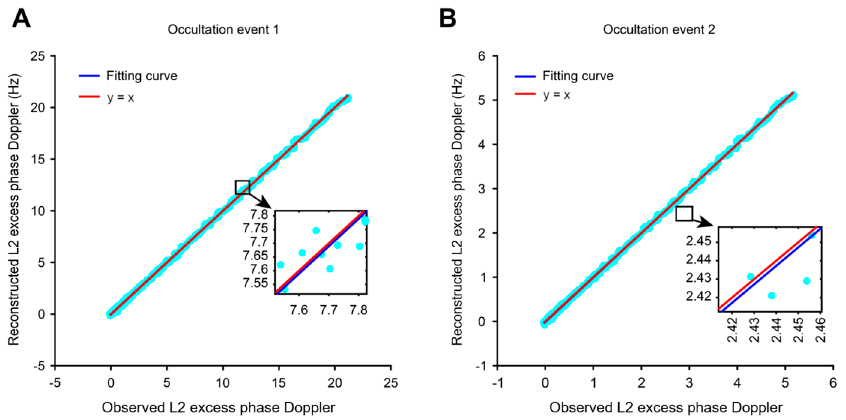
Figure 5. Consistency comparison between the excess phase Doppler of the reconstructed B ∗ excess phase Doppler of the actual observation B 3 , ( A ) is occultation event 1 and ( B ) is occultation event